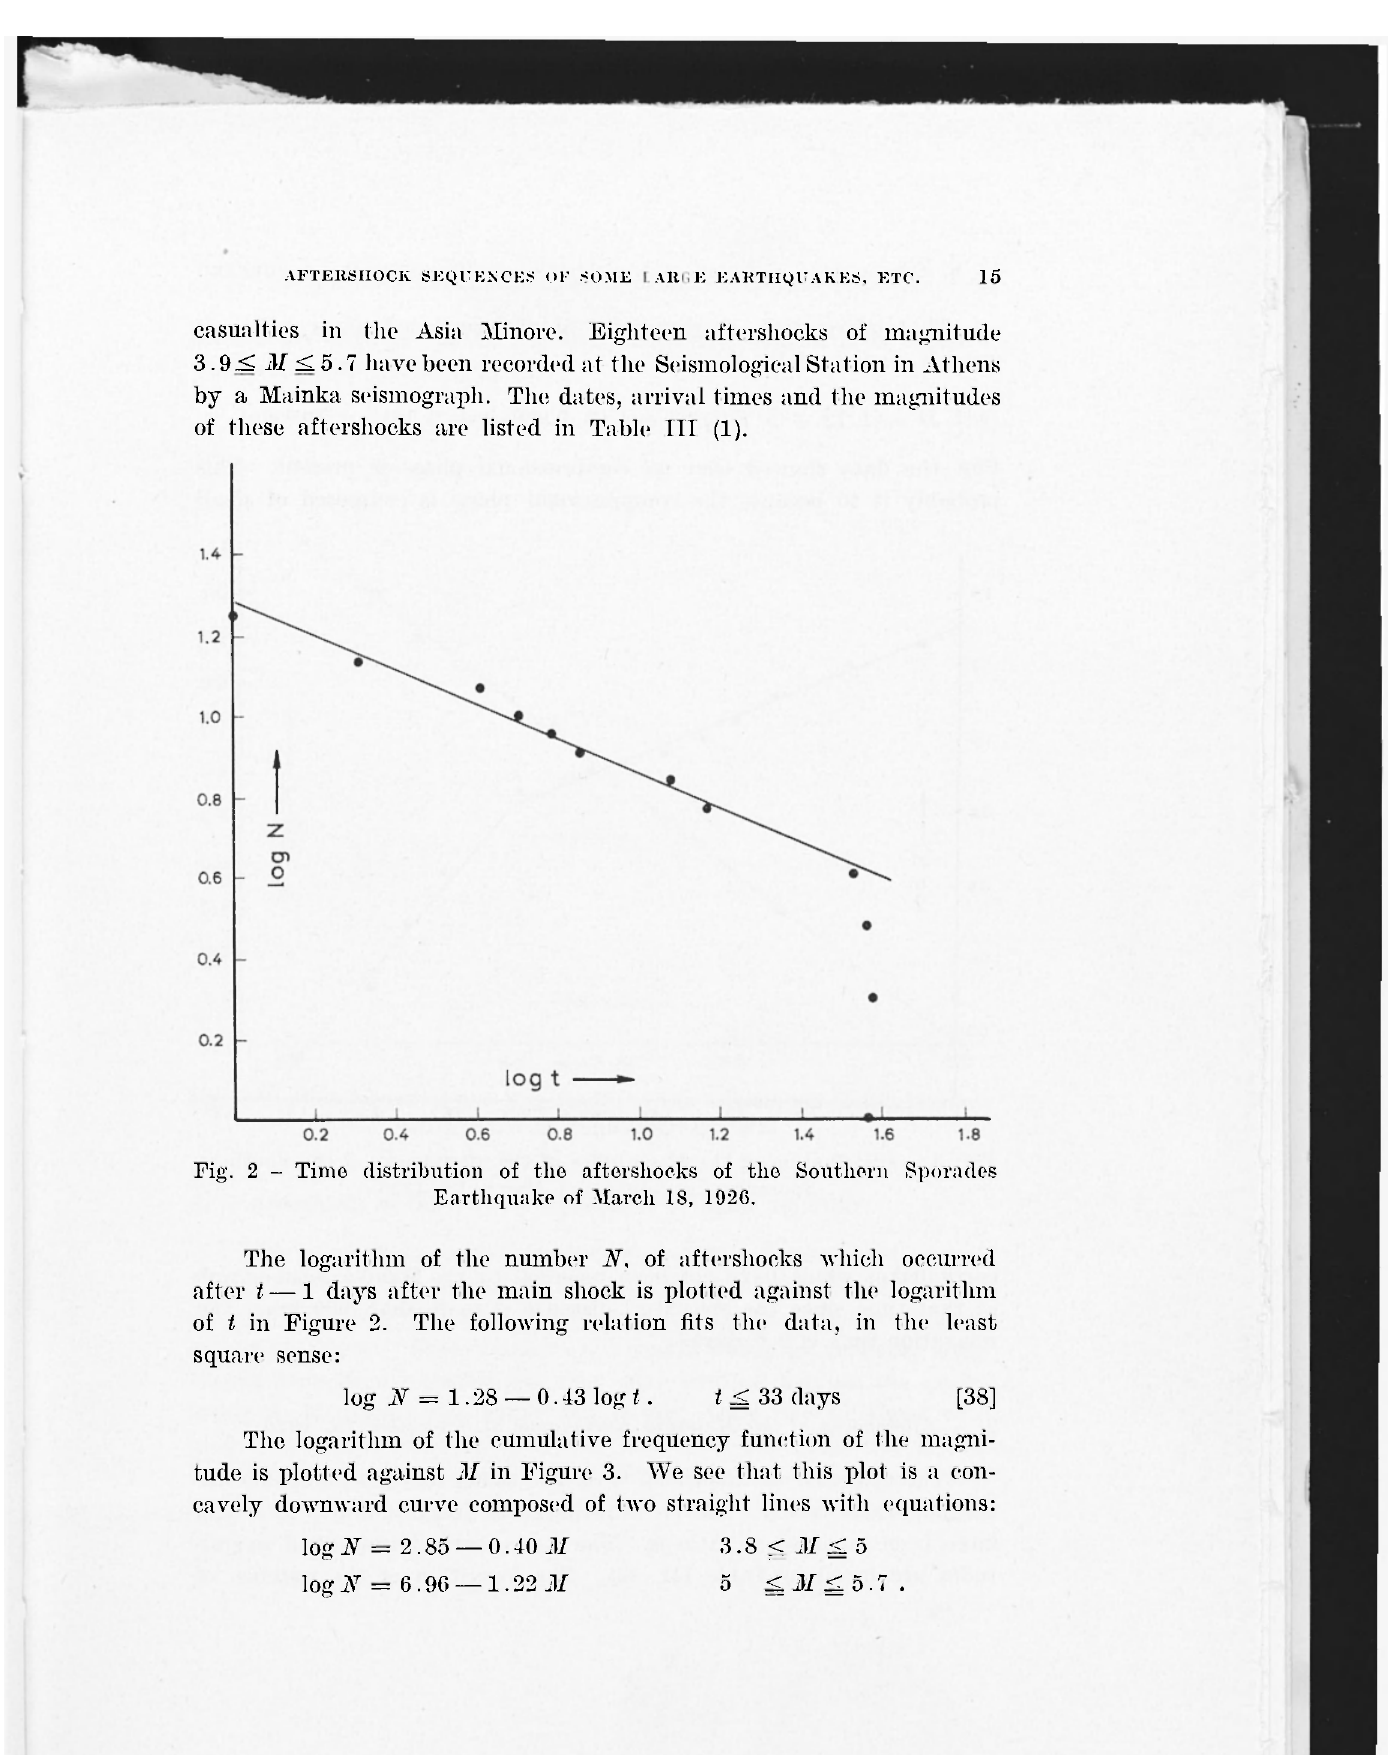
Fig. 2 - Time distribution of the aftershocks of the Southern Sporades Earthquake of March IS,